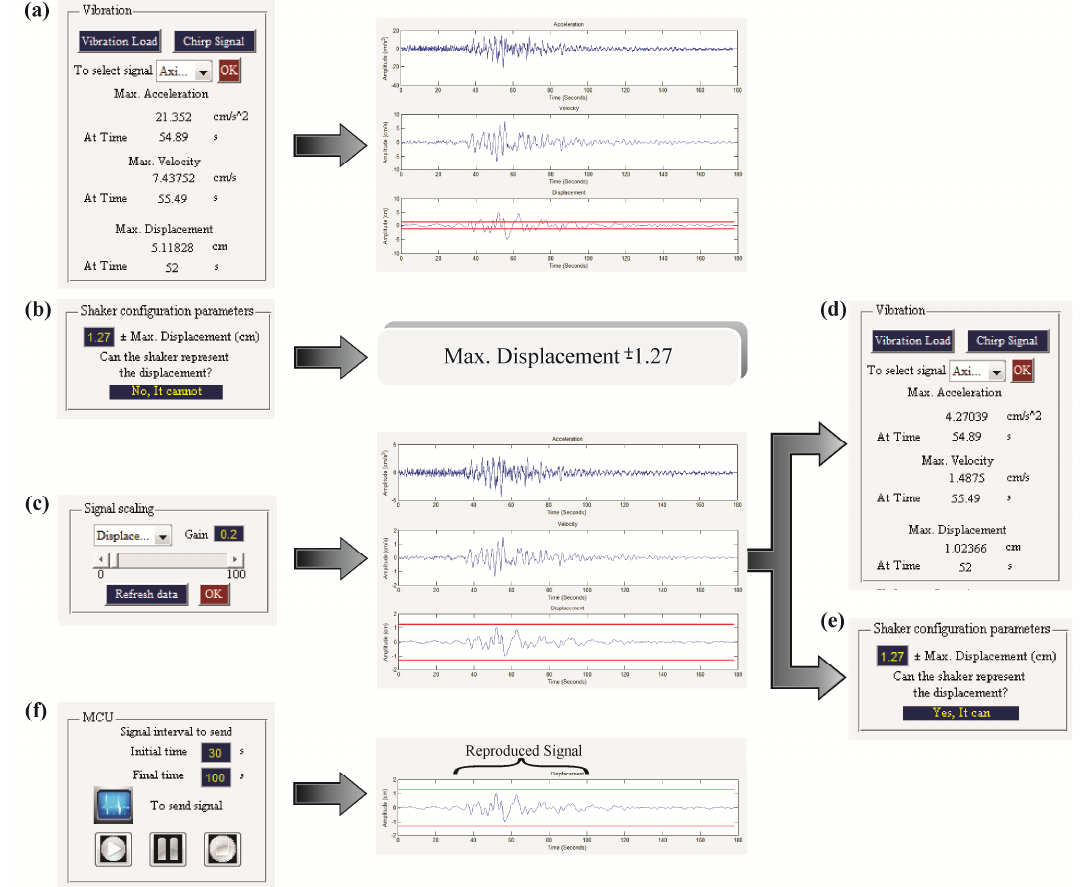
Fig. 4. Simulator